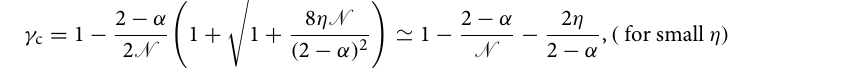
Figure 5. SNR ∗ of Eq. (5) in logarithmic scale as functions of γ and η for N eff The SNR ∗ s for the cases using the coherent (upper panel), TF state (low panel), and TMSV state (upper and lower panels where appropriate) are respectively shown in the regimes of small α (left column) and large α (right column). In lower panel, the region where SNR ∗ > 1 is clearly distinguished by the red dashed line according to Eq.